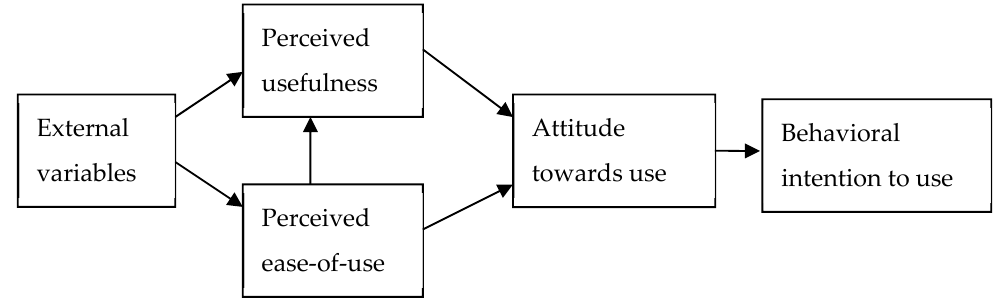
Figure 2. Technology acceptance model [16].